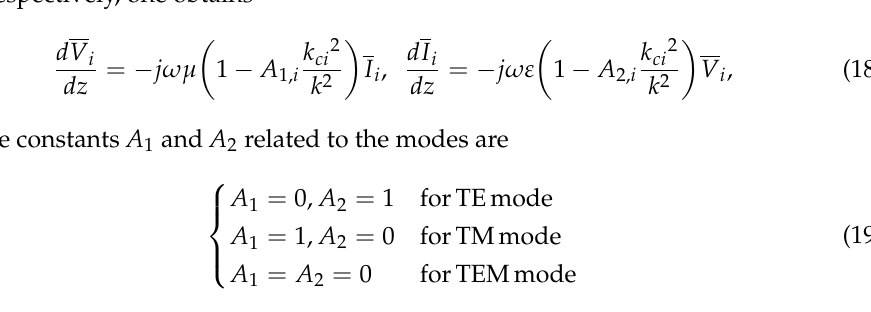
Figure 2. Equivalent modal excitation circuit for the WLTL.